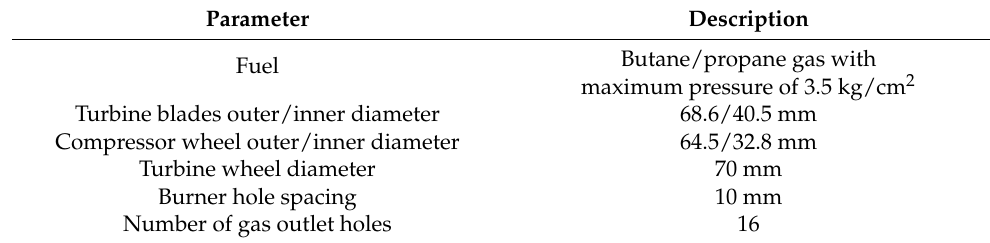
Table 1. Technical data for the microturbine.